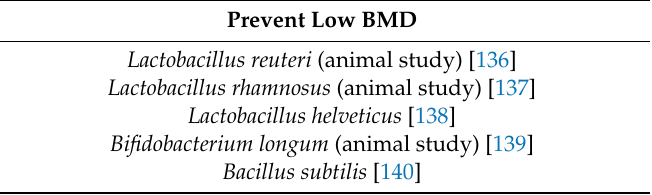
Table 5. Certain species that may prevent low bone mineral content